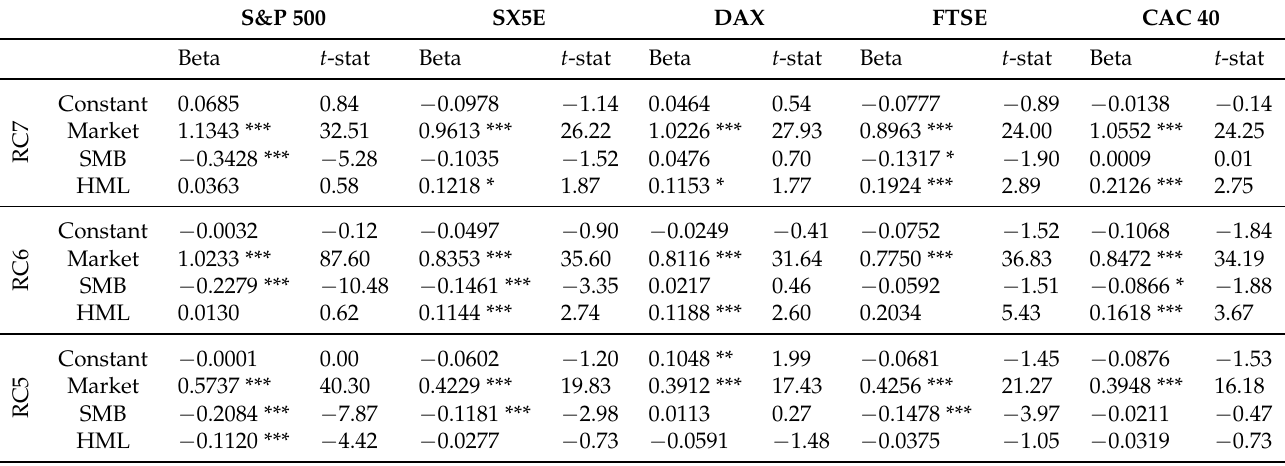
Table 4. This table shows the first set of results of the Fama–French three-factor regressions that were performed to verify if the volatility-based strategies yielded significant outperformance. Significance at a confidence level of 99%, 95%, 90% is indicated with ***, **, *, respectively. No significant alphas at the 99%-level could be found for the investment strategies based on the risk